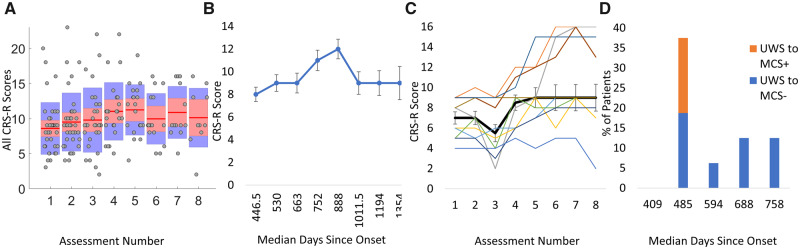

Patients’ behavioural recovery over time. (A) Boxplots showing the CRS-R scores of the patients across assessment. Red lines represent the medians and shaded areas represent the inter-quartile ranges. Individual scores are indicated as grey dots. (B) Illustration of the mean CRS-R scores plotted against the median days since onset (three patients’ data were removed from this graph as observations were >2 × SDs above the group mean). Error bars represent the standard errors for the group. (C) Trajectory of mean CRS-R scores (black line) of a subgroup of 10 patients who all had eight assessments. Standard error bars represent the standard error of the mean. Trajectories of individual patients in the group are plotted as thin coloured lines. (D) Stacked bar chart showing the proportion of UWS patients that changed diagnosis against the median days since injury onset at the time of the change.